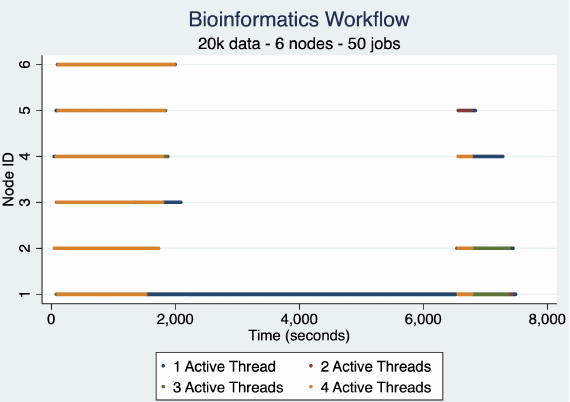
Figure 17. Number of Active Threads per node for a Bioinformatics Workflow with 20 k Data, 6 Nodes and 50